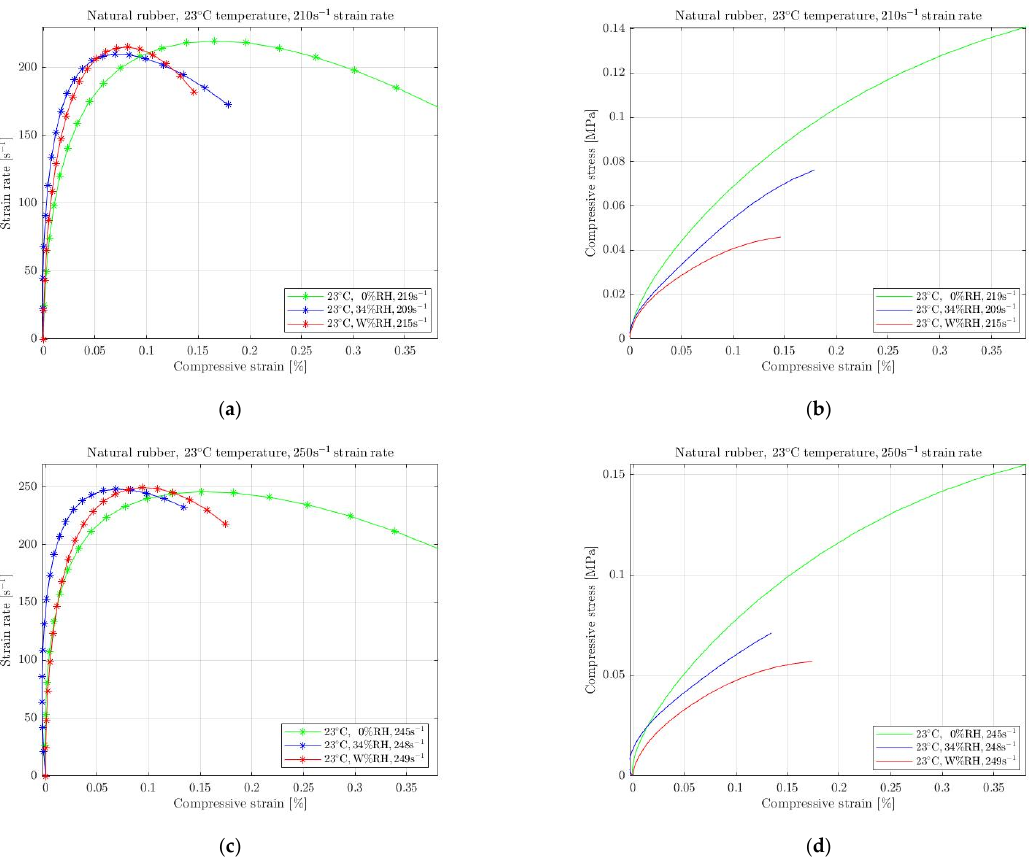
Figure 8. Strain rate vs. compressive strain ( a , c ) and compressive stress vs. compressive strain ( b , d ) of natural rubber subjected to absolute wet (W% RH) and dry (0% RH) conditions at 23 ◦ C temperature compared to the ambient conditions (34% RH) for 210 s − 1 ( a , b ) and 250 s − 1 ( c , d ) strain rate. In Figure 9, the results of silicone for 200 s − 1 (Figure 8a) and 270 s − 1 (Figure 8d) stain rates are presented. It is evident that the mechanical behaviour is highly affected when regulating moister from the ambient environment. Stress degradation was only recorded when the specimens were exposed to a wet environment, whereas for the conditions where humidity was entirely removed, specimens became stiffer. Hence, silicone’s re- sponse to changing humidity was recorded to be similar to the behaviour of natural rub- ber.